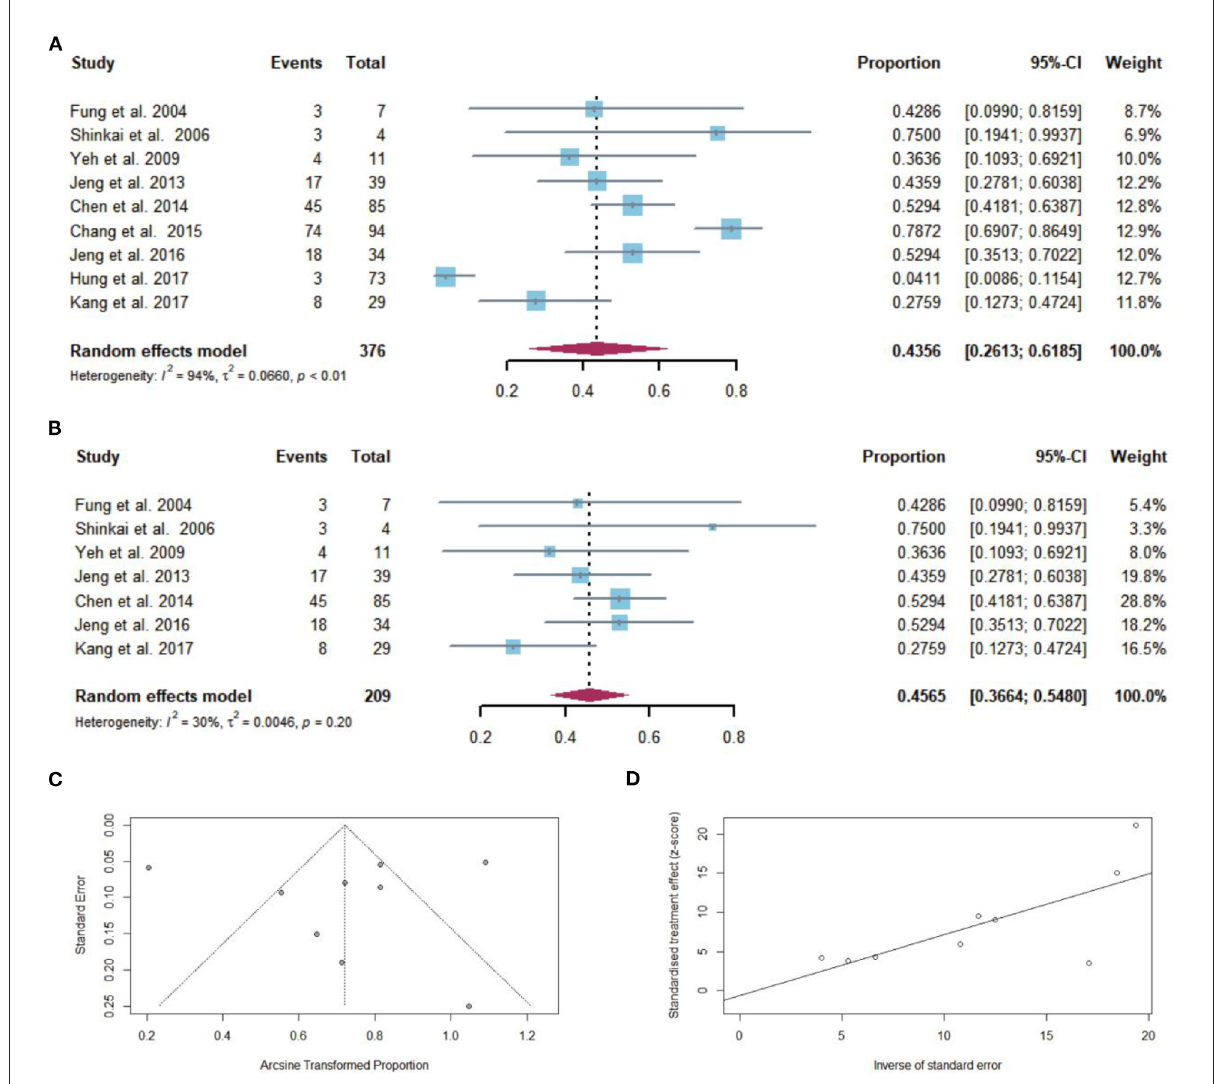
FIGURE4 (A) Individual estimate and pooled proportion of CR in cirrhotic patients after NAs discontinuation. (B) Sensitivity analysis of pooled proportion of CR in cirrhotic patients after NAs discontinuation excluding studies with high bias. (C) Funnel plot. (D) Egger’s test.